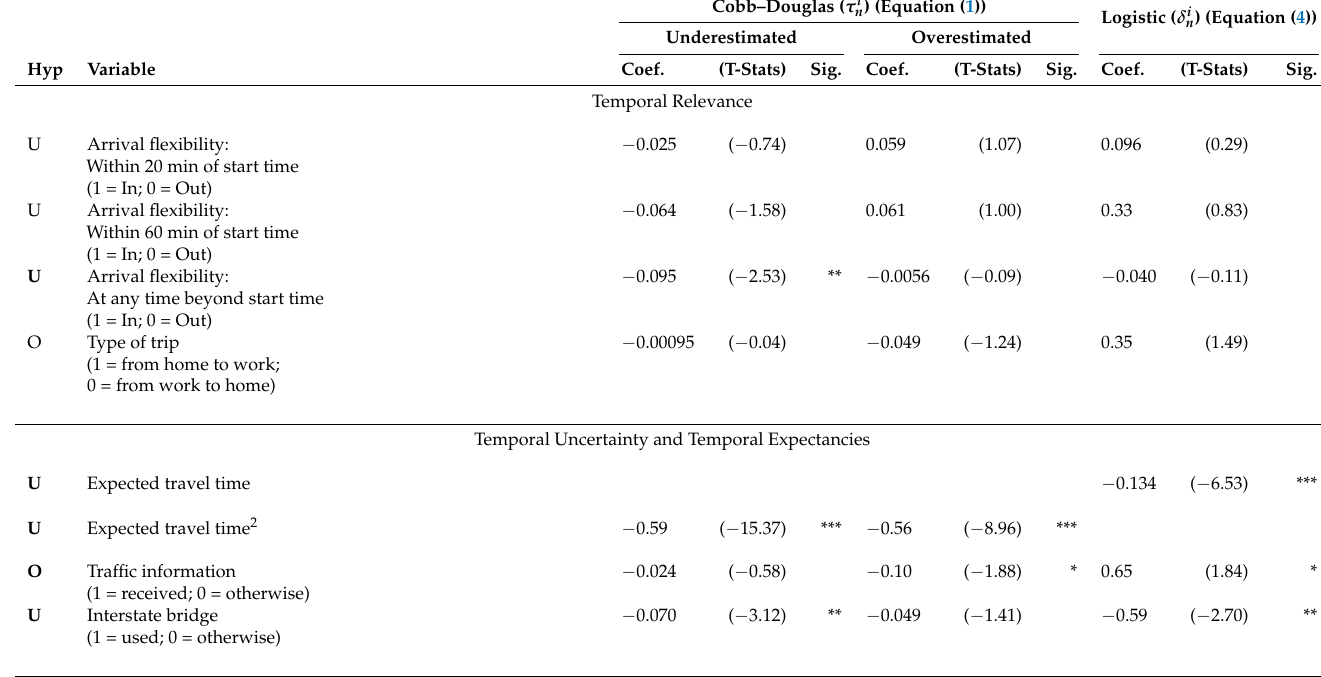
Table 2. Regression